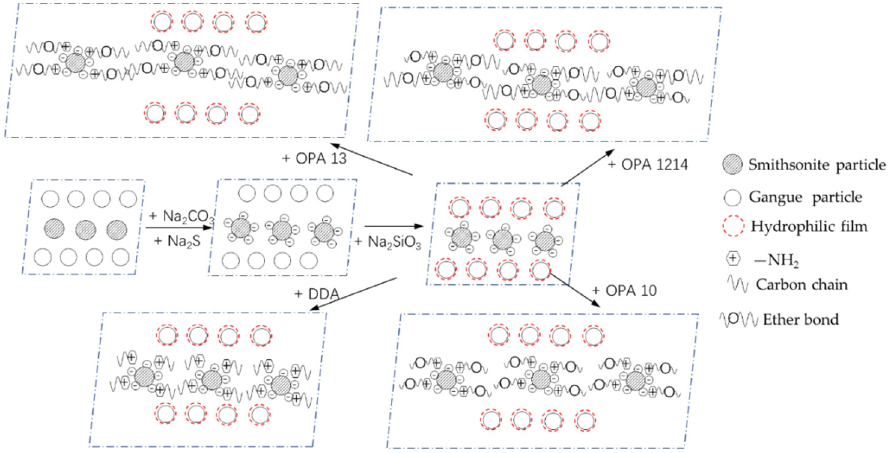
Figure 10. Schematic of mechanisms by which four amines affect smithsonite flotation.